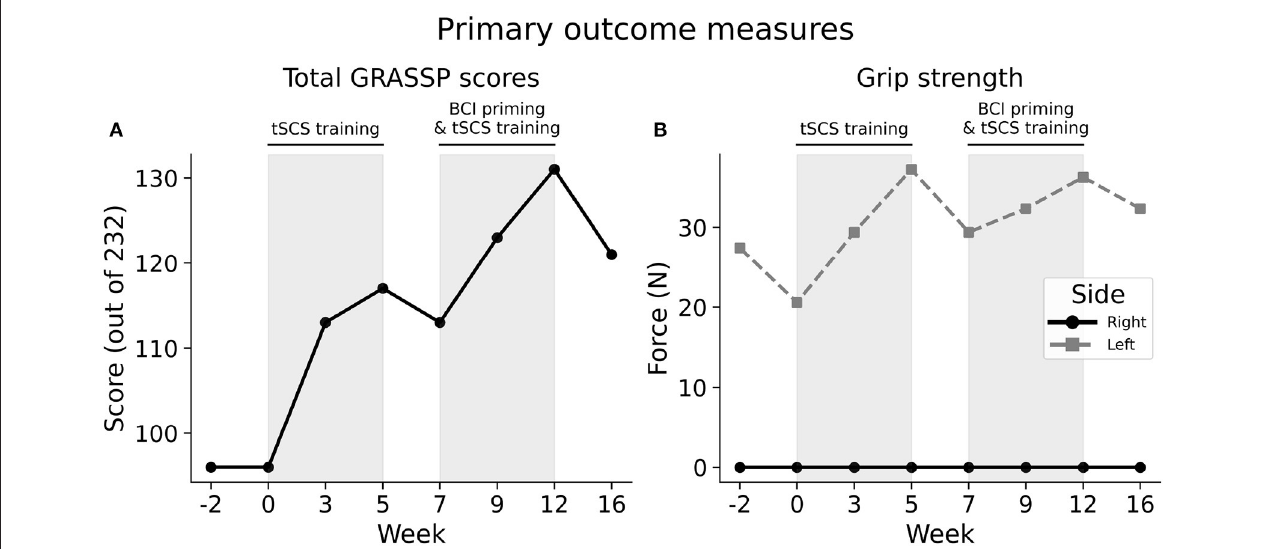
FIGURE 2 | Upper-extremity primary outcome measures. (A) Score totals from the Graded Redefined Assessment for Strength, Sensibility, and Prehension (GRASSP) across the study. Shaded areas indicate the two therapeutic phases: “tSCS training” and “BCI priming & tSCS training”. (B) The participant’s hand grip strength across study. The left and right hand is indicated with a gray dashed and solid black line, respectively.